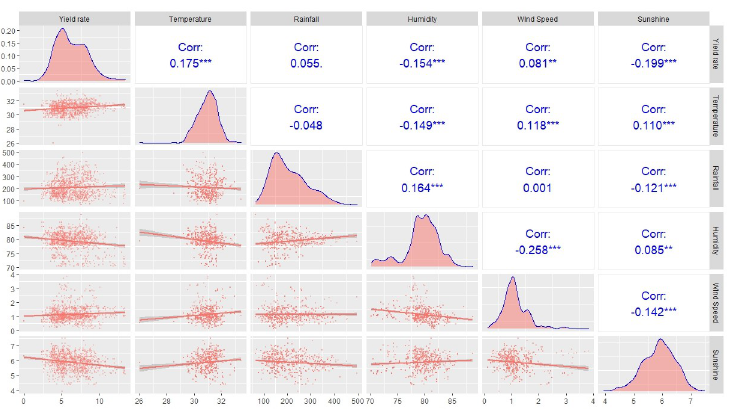
Fig 2. Matrix scatter plot of the selected variables. ��� refers p-value < 0.001, �� refers p-value < 0.05 and � refers p- value < 0.1.